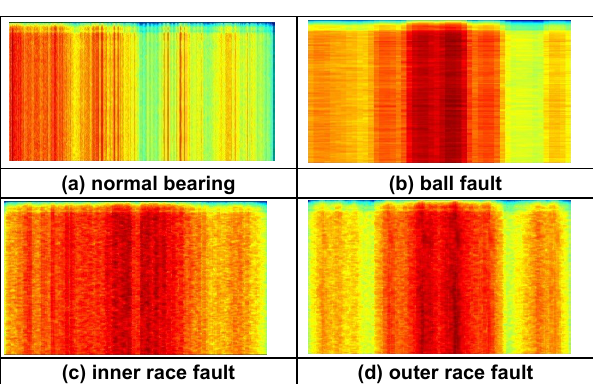
Figure 4: FFT plot at 1750 rpm category: (a) normal, (b) ball fault, (c) inner race fault (d) outer race fault.